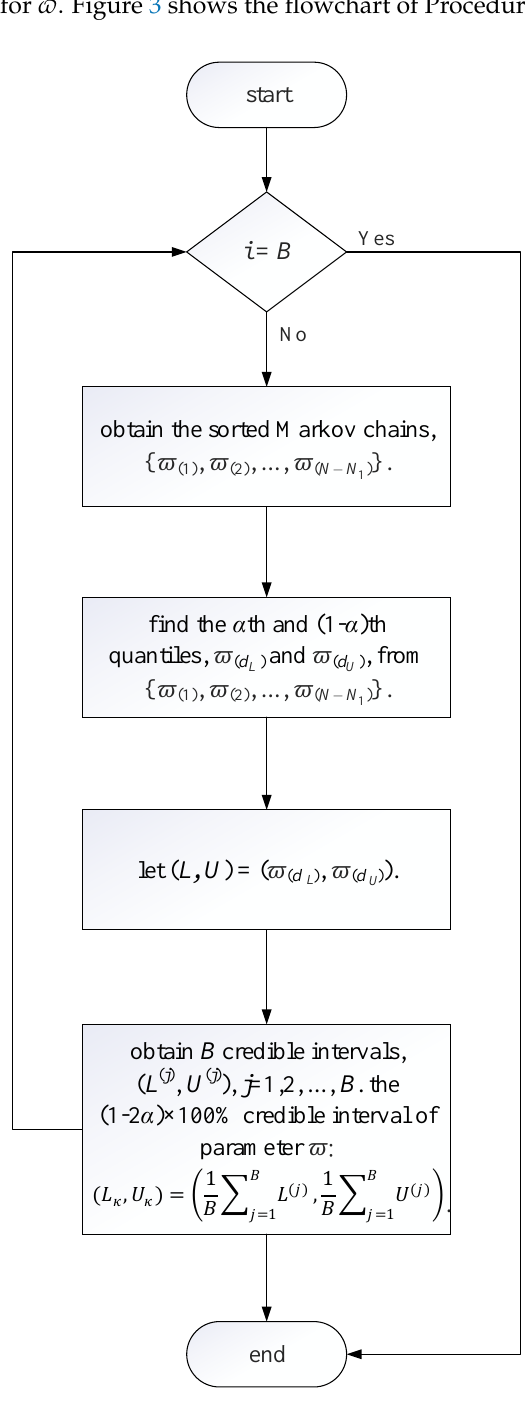
Figure 3. The flowchart of Procedure